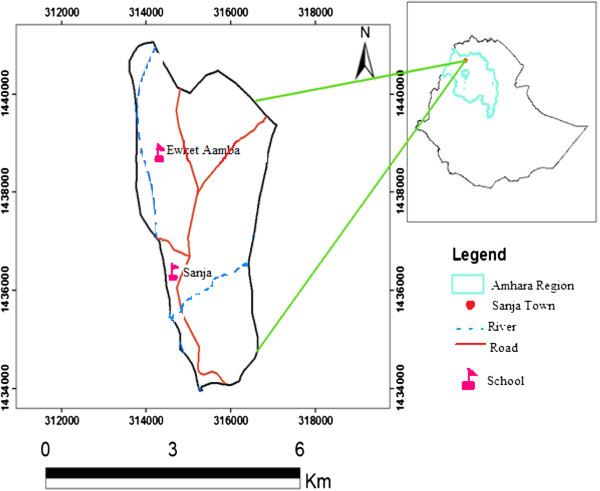
Map of study area.